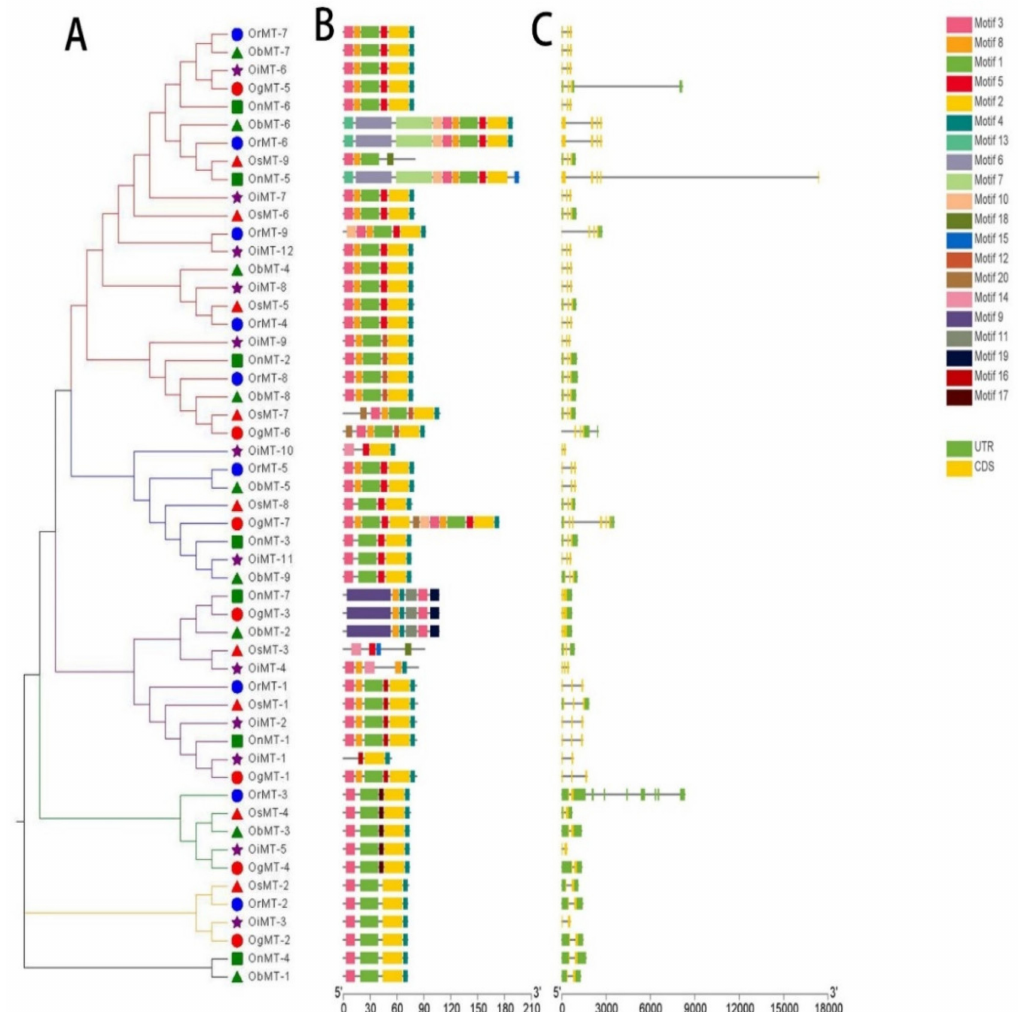
Figure 2. The phylogenetic tree ( A ), motif composition ( B ), and exon/intron structure ( C ) of the MT genes in six Oryza species/subspecies. ( A ) Sequence alignments and the NJ-phylogenetic trees were made using ClustalW and MEGA v.7.0, respectively. A bootstrap number (1000 replicates) is adopted; ( B , C ) the widths of the gray bars represent the relative lengths of genes and proteins. The green boxes and gray lines display exons and introns,